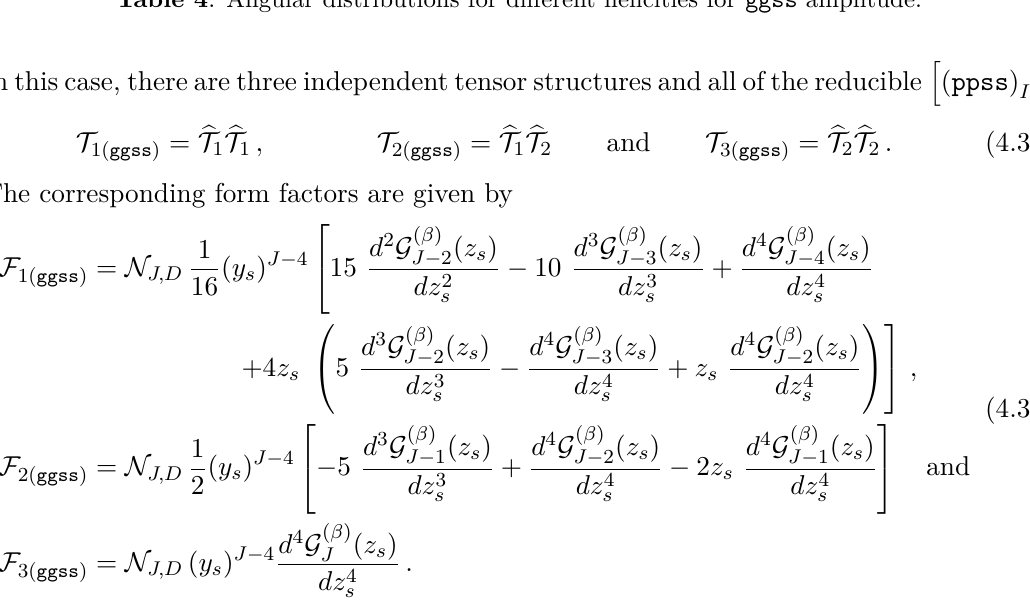
Table 4 . Angular distributions for different helicities for ggss